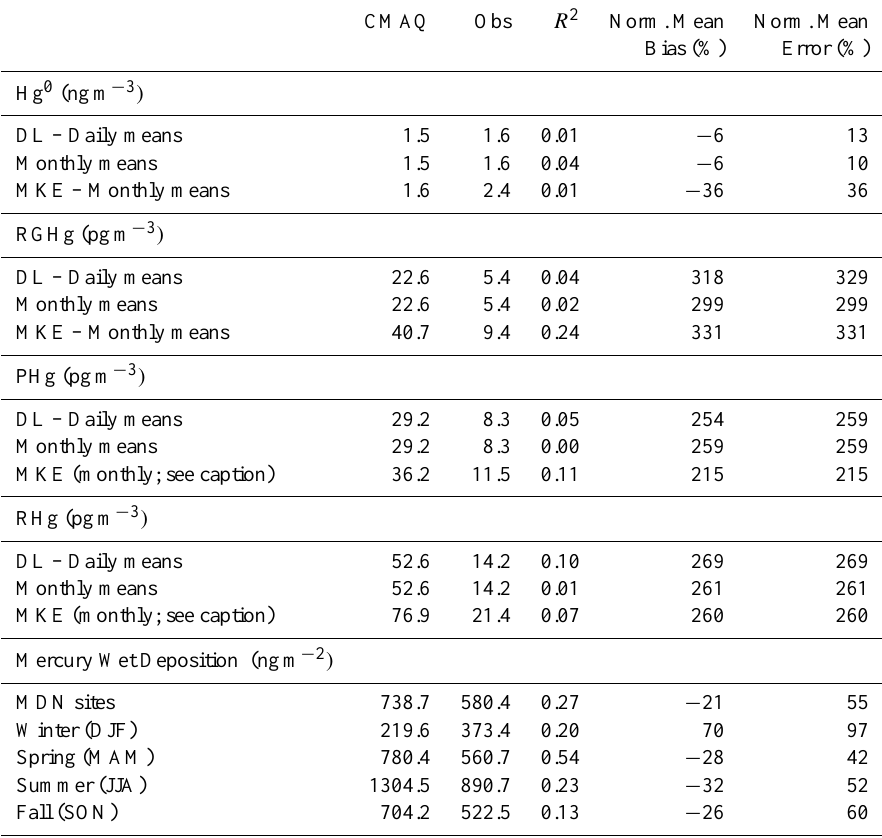
Table 1. Mean values and evaluation metrics are presented to compare CMAQ-Hg Hg 0 (units ngm − 3 ) , RGHg, PHg, and RHg ( = RGHg + PHg, units pgm − 3 ) at DL and MKE. Equations (1) and (2) used to calculate normalized mean bias and error. All model and measurement data from 2003, except for ambient mercury species at MKE, as discussed in the text. Evaluation of mercury wet deposition across the GLR region (units ngm − 2 ) compares CMAQ-Hg with 31 MDN monitors. CMAQ Obs R 2 Norm. Mean Norm.